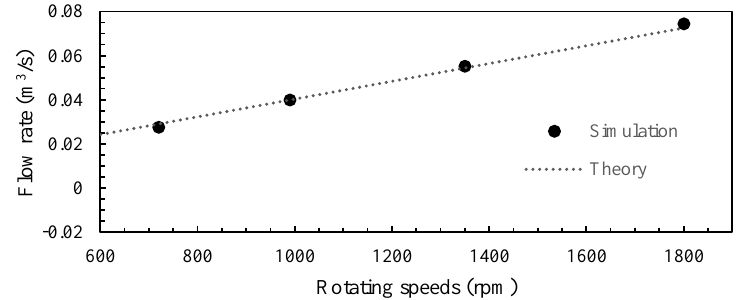
ff erent rotating speeds of the fan.